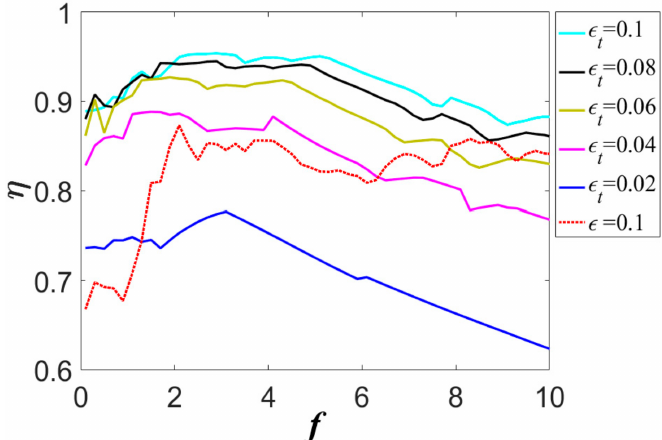
Figure 12. The energy dissipation ratios of single NES and five NESs with shock amplitude (the solid line represents the five NESs, the dashed line represents the single